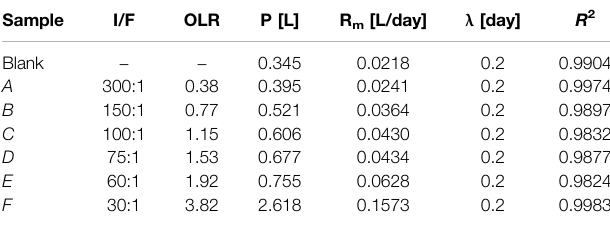
TABLE 7 | Modi fi ed Gompertz kinetic model of CMFW biogas